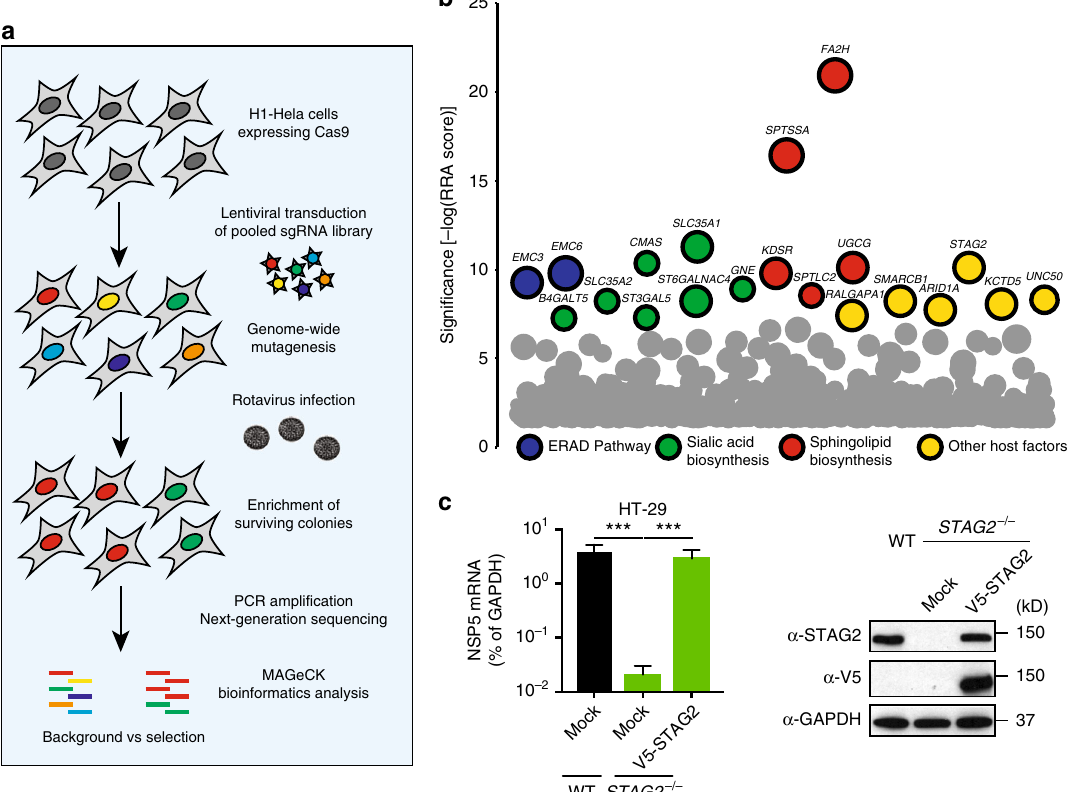
Fig. 1 A genome-wide CRISPR-Cas9 screen reveals STAG2 as a pro-RV host factor. a Schematic fl owchart for RV CRISPR-based loss-of-function screening approach. b Bubble plot of host factors essential to RV infection. The top 20 genes were colored and grouped by function. Size of bubbles corresponds to the number of signi fi cant sgRNAs scored for each gene. c Wild-type (WT), STAG2 − / − , and STAG2 − / − HT-29 cells transduced with V5-tagged STAG2 were infected with RV (MOI = 1) and viral NSP5 mRNA level was measured at 24 h.p.i. by RT-qPCR (left panel). Cell lysates were analyzed by western blot with the indicated antibodies (right panel). For c , experiments were repeated at least three times in triplicates. Data are represented as mean ± SEM (*** P ≤